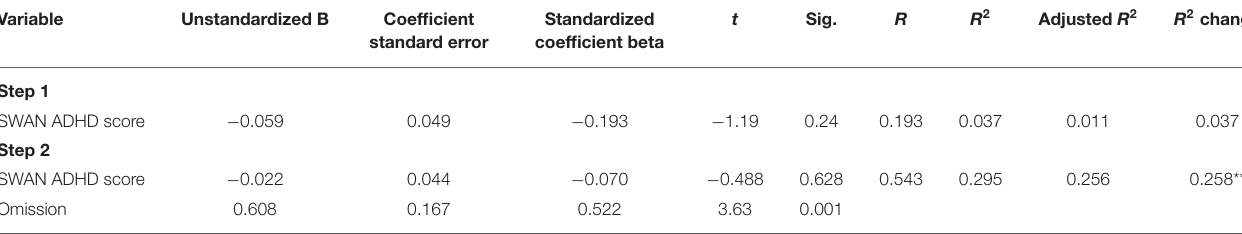
TABLE 8 | Regression model of the CCPT measures as the predictors of the CBCL withdrawn subscale score in the SCT group. Variable